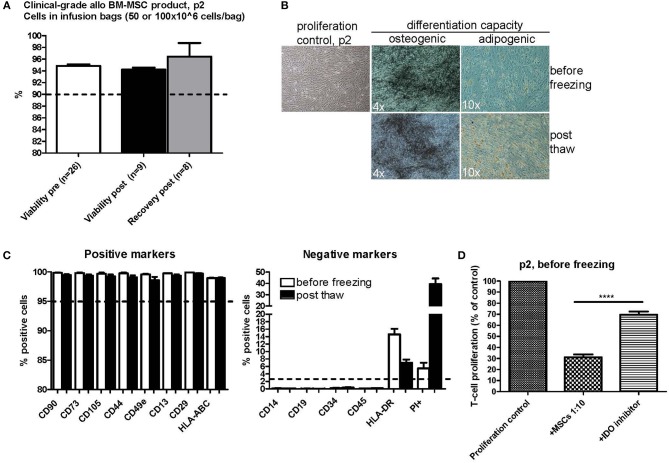
Characterization of clinical-grade allogeneic BM-MSC product in passage 2 before and after one freezing step. (A) Viability before freezing (white) and after thawing (black) and cell recovery after thawing (gray). The cells were frozen at passage 2 in freezing bags with either 50 or 100 × 106 cells/bag. Results are presented as mean ± SEM. The viability differences were non-significant (p-value 0.1716 with a non-parametric two-tailed t-test and 95% confidence interval). (B) Osteogenic and adipogenic differentiation capacity of MSCs before and after freezing. Representative phase contrast microscope pictures are presented (n = 3). Enlargement is indicated in each picture separately. (C) MSC phenotype before (white) and after (black) freezing as studied by flow cytometry. Results are presented as mean ± SEM (n = 3). (D) T-cell proliferation assay results of clinical-grade MSCs in passage 2 before freezing with IDO inhibition. Results are presented as mean ± SEM (n = 16). 1-Methyl-L-Tryptophan (L-1MT) was utilized as an IDO inhibitor. ****p < 0.0001.